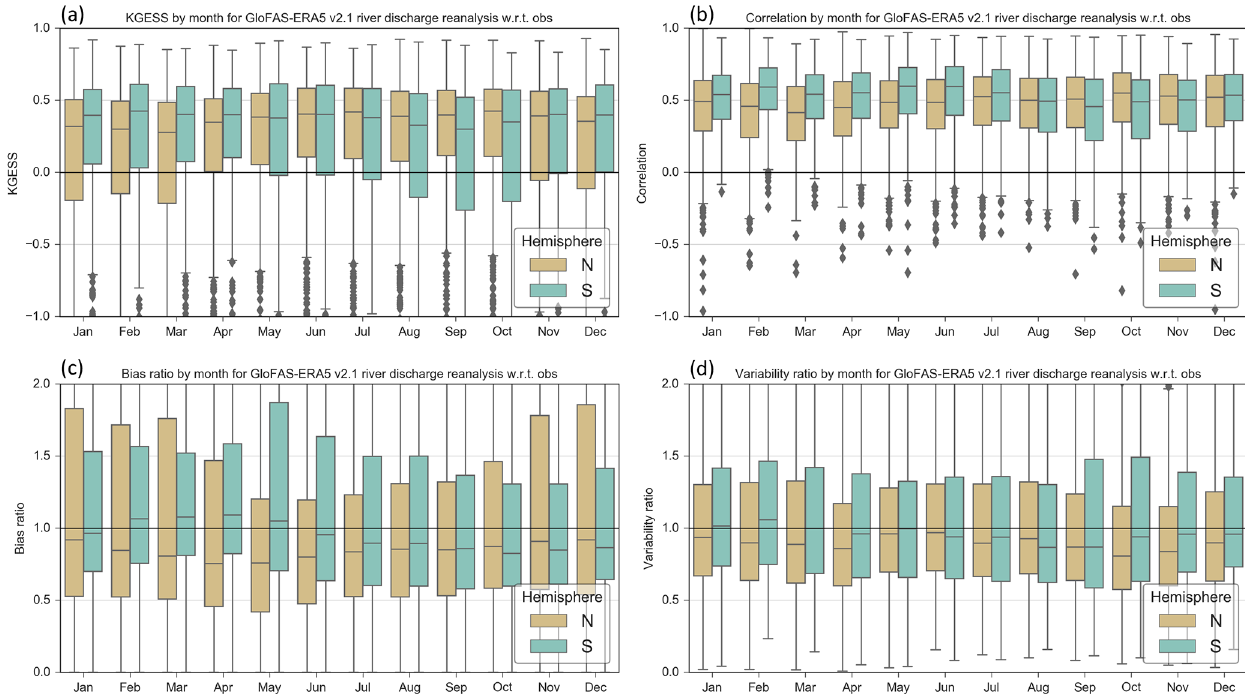
Figure 9. As in Fig. 8 but by hemisphere: Northern Hemisphere ( n = 1268 stations) as brown boxes and Southern Hemisphere ( n = 533 stations) as green boxes.